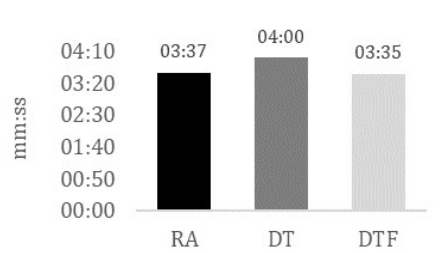
Figure 9. Participants’ average task durations with the RA, DT and DTF.